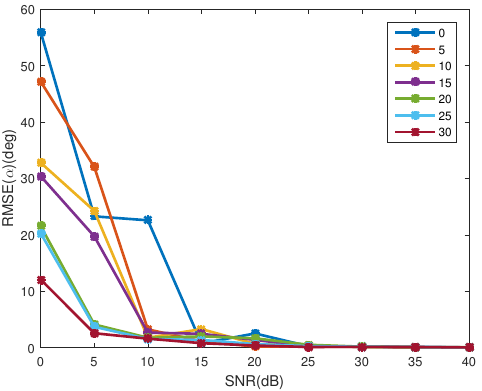
Figure 12. The estimating error of coning angle at different coning angles. Different colors represent different coning angles, which range from 0 ◦ to 30 ◦ with step of 5 ◦